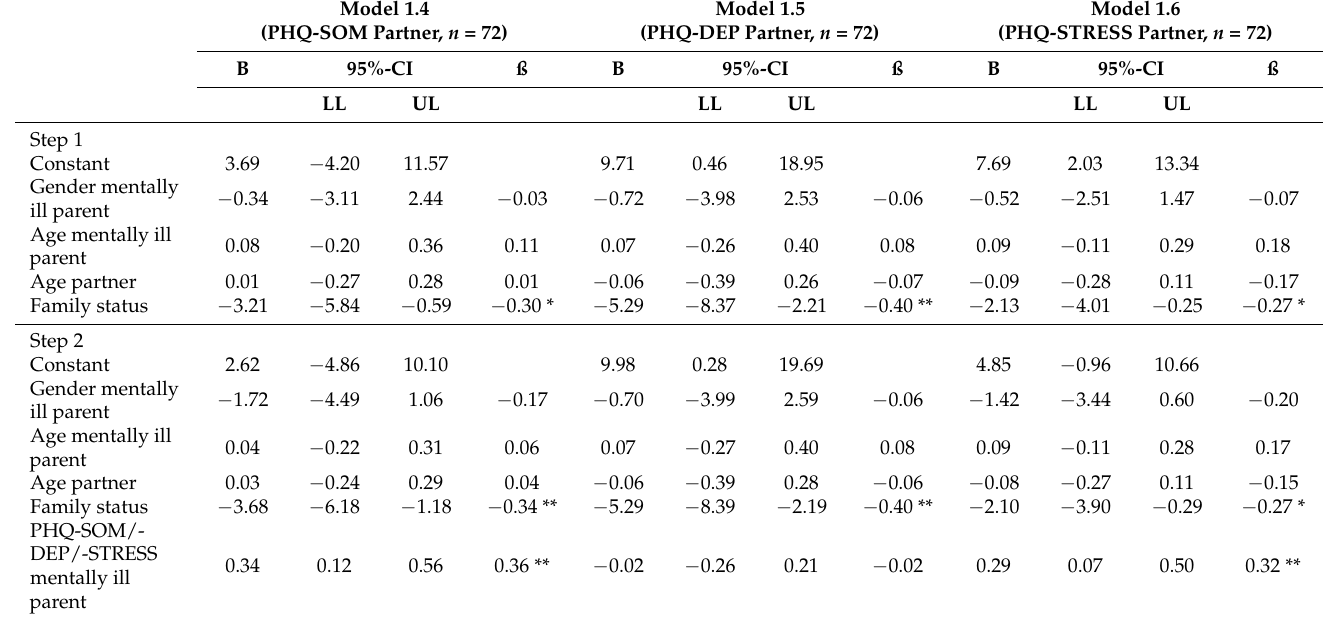
Table 4. Hierarchical regression analyses predicting partners’ symptomatology using PHQ